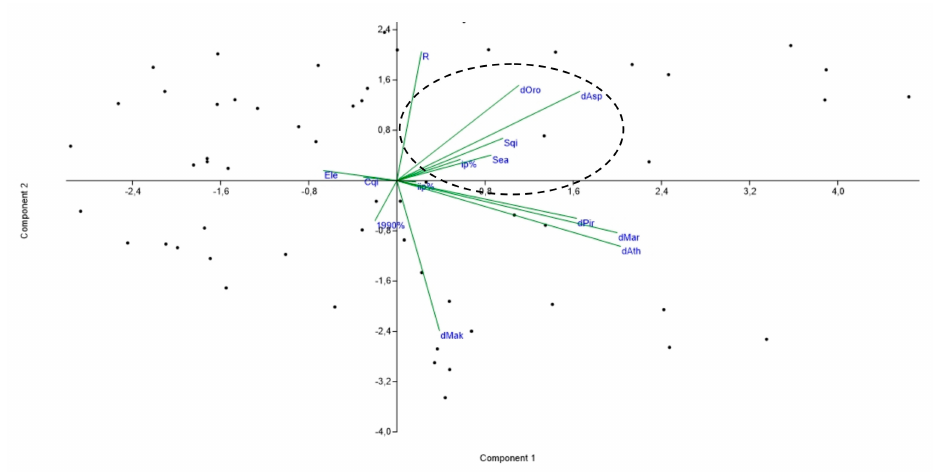
Figure 7. Biplot of a principal component analysis of the increase (or decrease) in the number of settlements supplemented with contextual indicators in the study area (acronyms in Section 2.3).